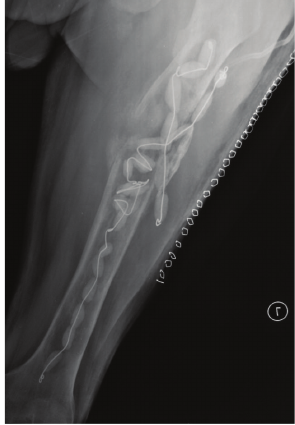
Figure 3: Lamellar cuticular membrane with giant cell and histio- cytic reaction seen between the fibrovascular tissues in pathological specimen.